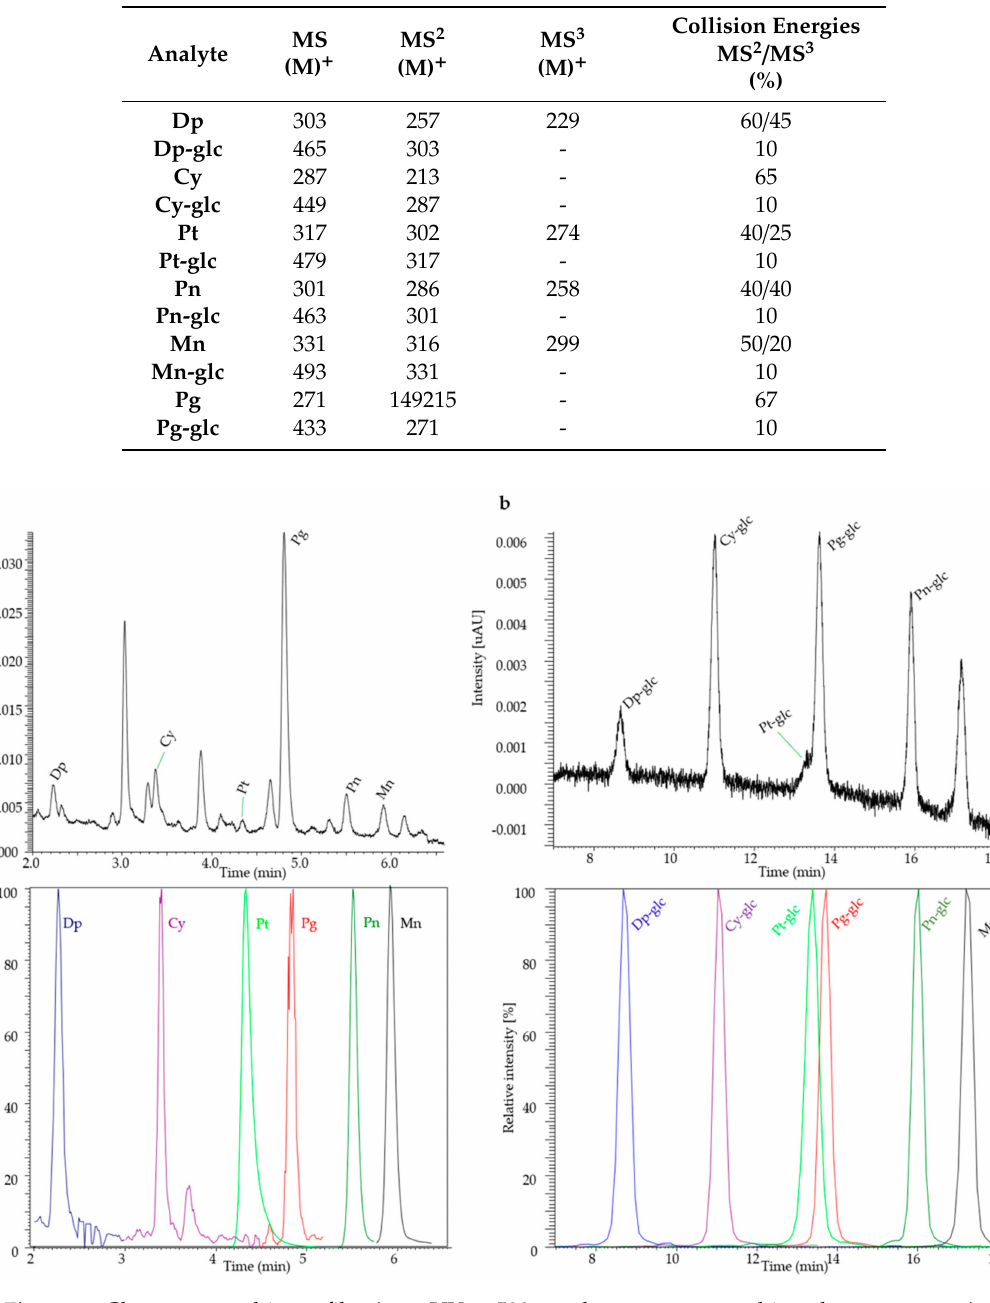
Table 2. Consecutive reaction monitoring (CRM) transitions of anthocyanins and anthocyanidins.